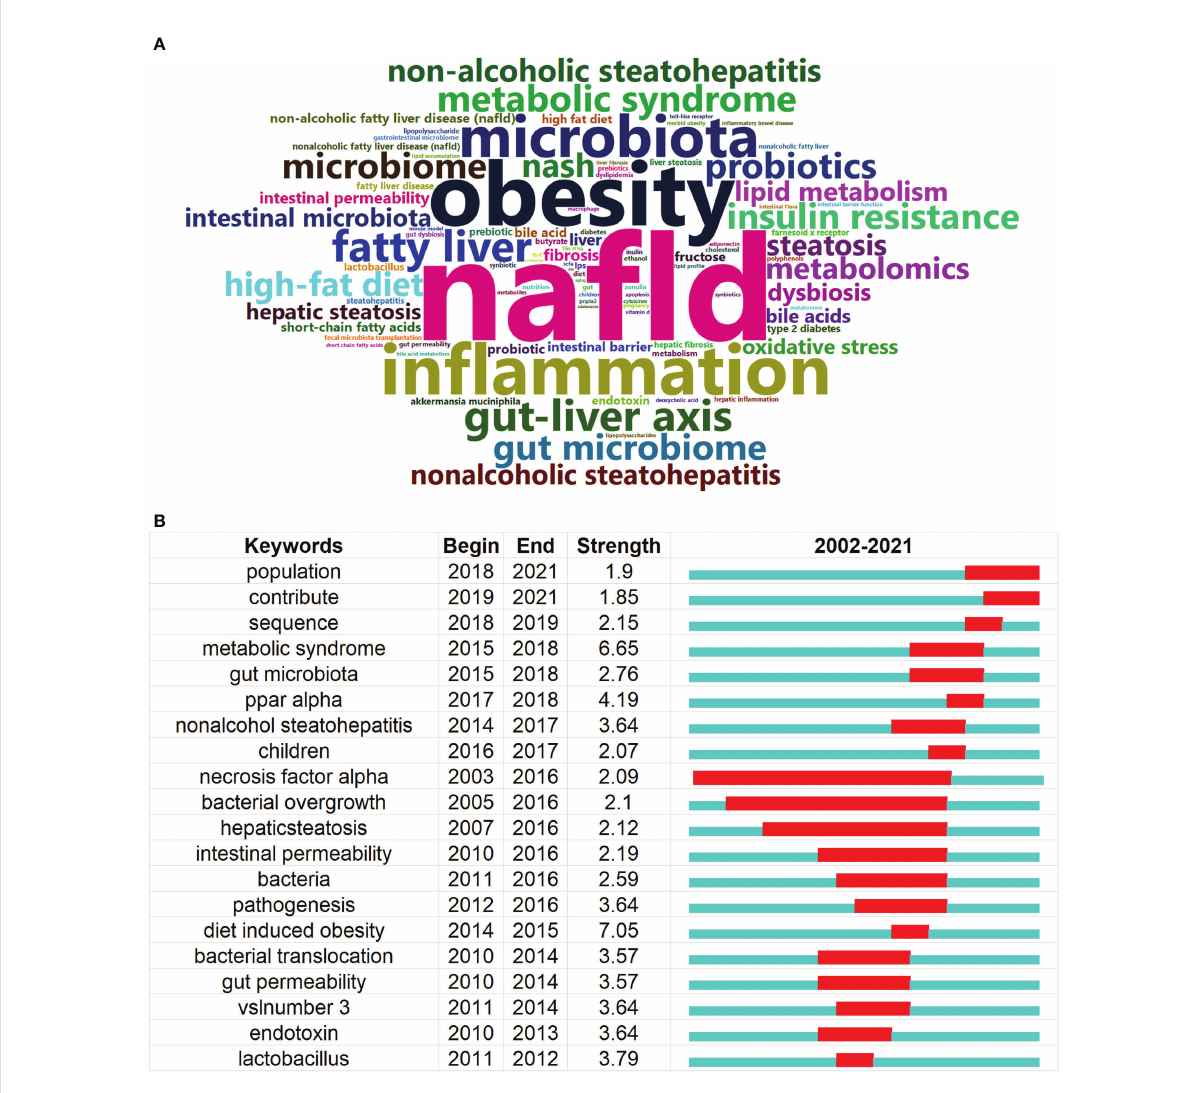
FIGURE 8 Analysis of Keywords and Burst Detection of publications on the links between the gut microbiota and MAFLD between 2002 and 2021. (A) Word cloud of the top 100 high-frequency keywords on the links of gut microbiota and MAFLD research via the R package bibliometrix (B) Keywords with the strongest burst strength of the 707 citing articles on the links of gut microbiota and MAFLD research between 2002 and 2021. Keyword marked in red indicates a sudden increase in usage frequency of this keyword during that period. Blue represents a relatively unpopular time